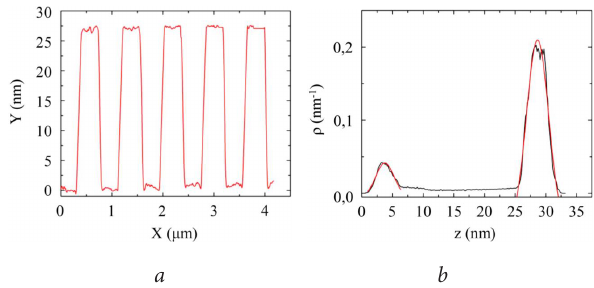
Fig. 3. AFM analysis of structure : a – Topology of structure etched to the surface (period 800 nm); b – Statistic function